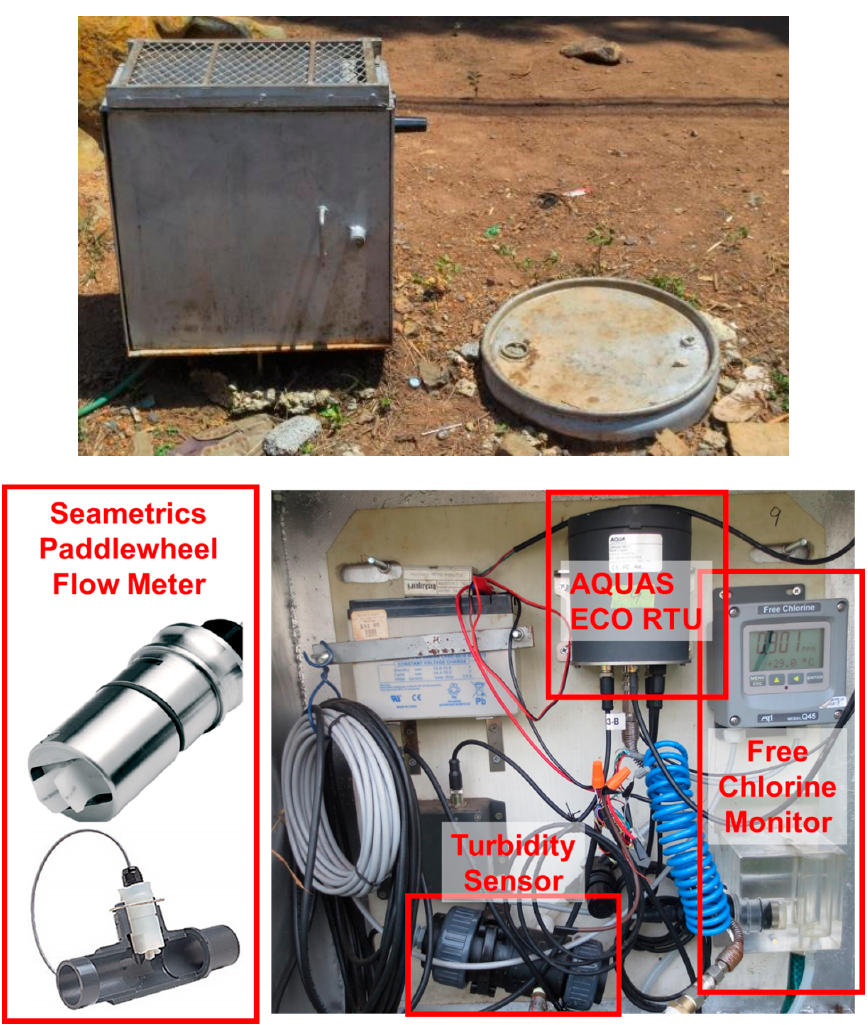
Figure 3. Continuous monitoring station ( top ) and sensors ( bottom ).